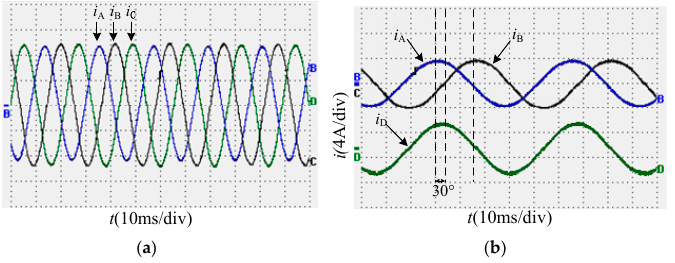
Figure 24. Waveform of motor under stable operation at 500 r/min: ( a ) current waveform of phase a , b , and c ; ( b ) current waveform of phase a , b , and d .